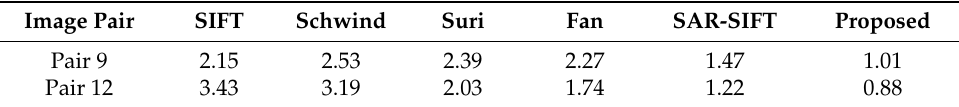
Table 12. Root mean square error (unit: